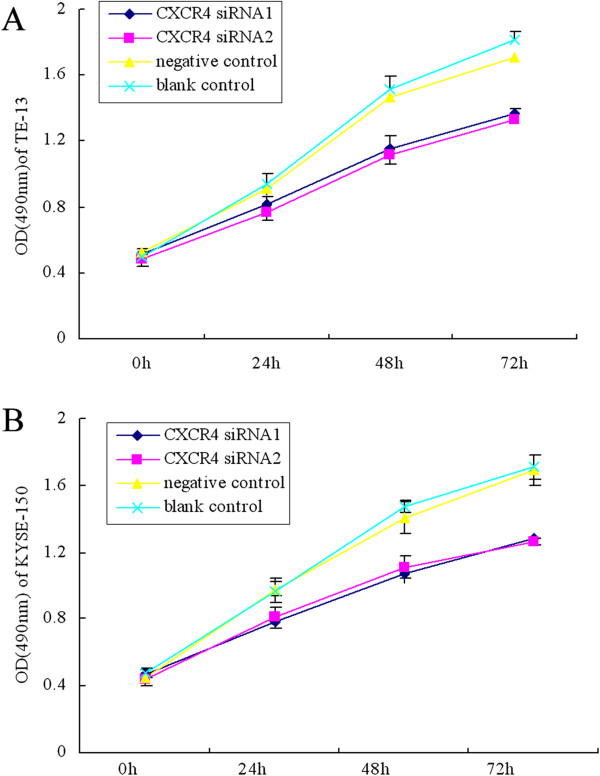
siRNA CXCR4 inhibited esophageal carcinoma cells proliferation in vitro. A. TE-13 cells were incubated with different synthetic oligonucleotides as described in the materials and methods section, and cells proliferation was detected by MTT assay. The targeted CXCR4 siRNA inhibited esophageal carcinoma TE-13 cell proliferation. B. KYSE-150 cells were incubated with different synthetic oligonucleotides as described in the materials and methods section, and cells proliferation was detected by MTT assay. The targeted CXCR4 siRNA inhibited esophageal carcinoma KYSE-150 cell proliferation.